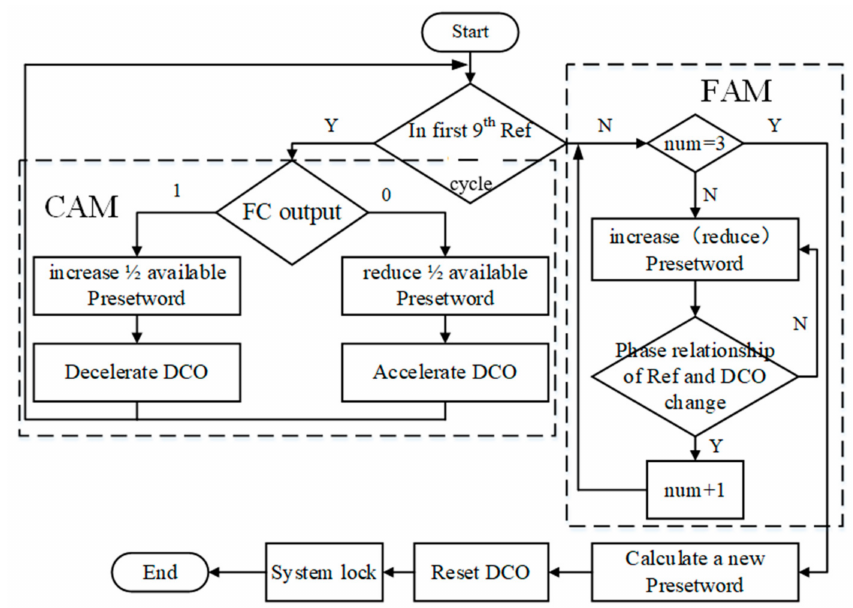
Figure 6. Flowchart of the Control module (num is the number of changes in the relationship between f div and f ref